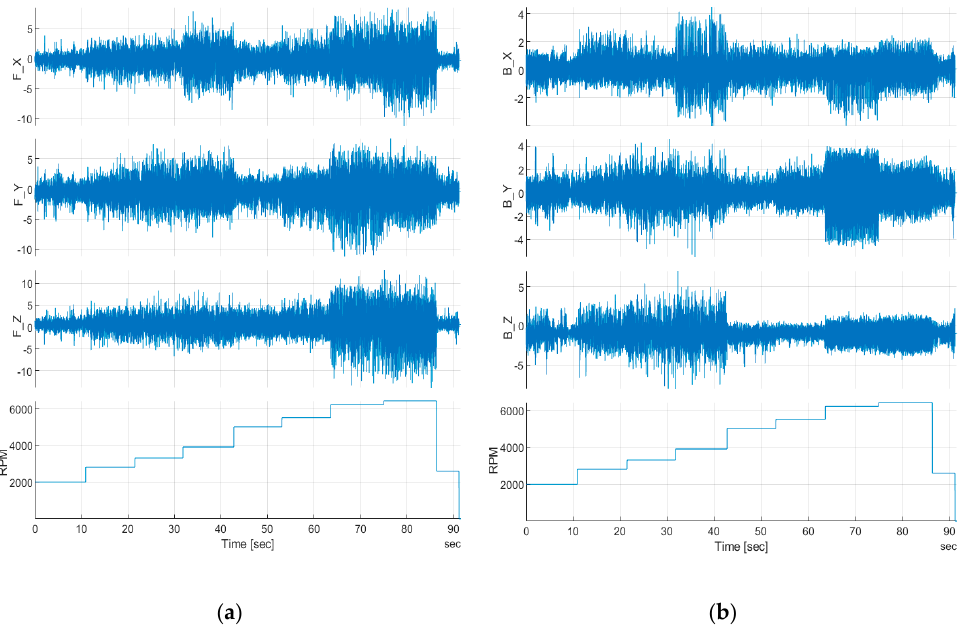
Figure 21. Strain measured on the wing and fuselage during the engine test ( a ) wing bending in the vertical plane – inner section ( b ) wing bending in the vertical plane – middle section ( c ) wing bending vertical plane—inner section ( b ) wing bending in the vertical plane—middle section ( c ) wing bending y -axis and ± 4 g for the x -axis. Above 4000, the envelope for each axis decreased by approximately in the horizontal plane – inner and middle section, ( d ) fuselage parachute attachment points. in the horizontal plane—inner and middle section, ( d ) fuselage parachute attachment points. 50%.